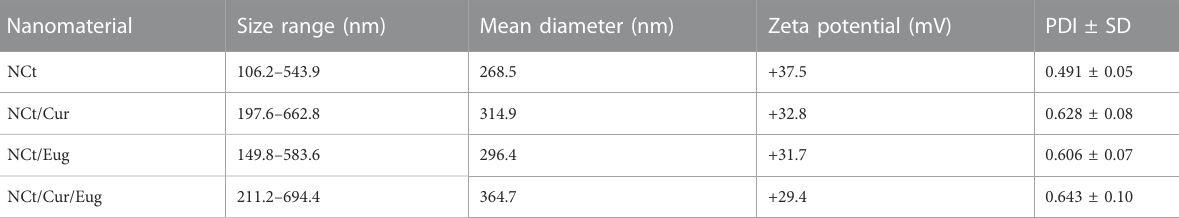
TABLE 1 Size distribution and zeta potentials of fabricated nanoparticles a